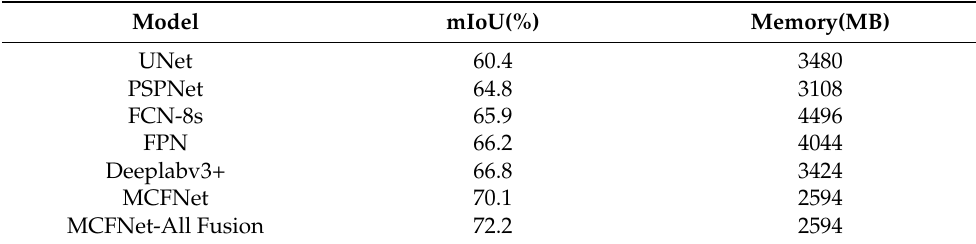
Table 4. Performance of MCFNet and other segmentation models on DeepGlobe Dataset.